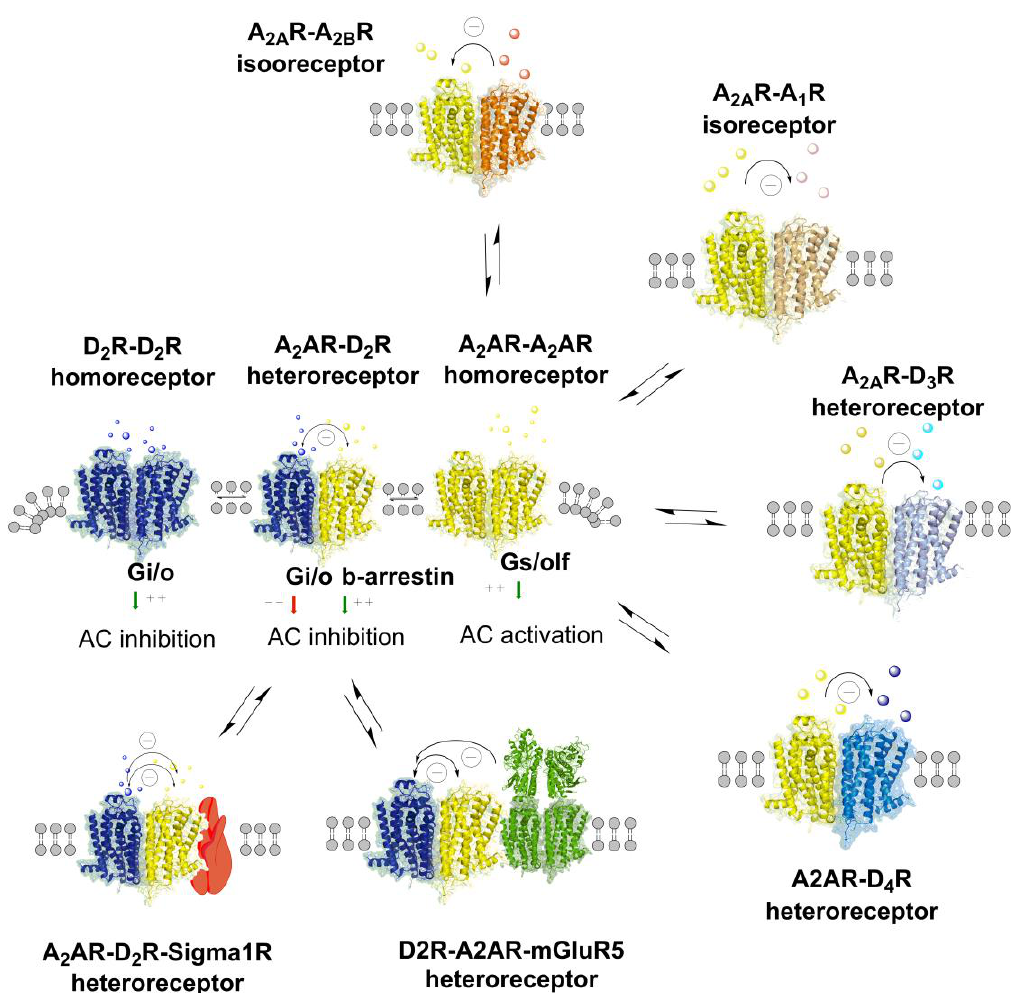
Figure 1. A 2A -D 2 heteroreceptor complexes, A 2A isoreceptor complexes, and higher order A 2A -D 2 heteroreceptor complexes are illustrated and exist mainly in the ventral and dorsal striatum. Their balance with the A 2A and D 2 homoreceptotor complexes are indicated as well as their allosteric receptor–receptor interactions. The nature of the allosteric receptor–receptor interactions in each complex is provided in the top part of the receptor complex. Antagonistic allosteric modulation is indicated as (-) and facilitatory allosteric modulation as (+).